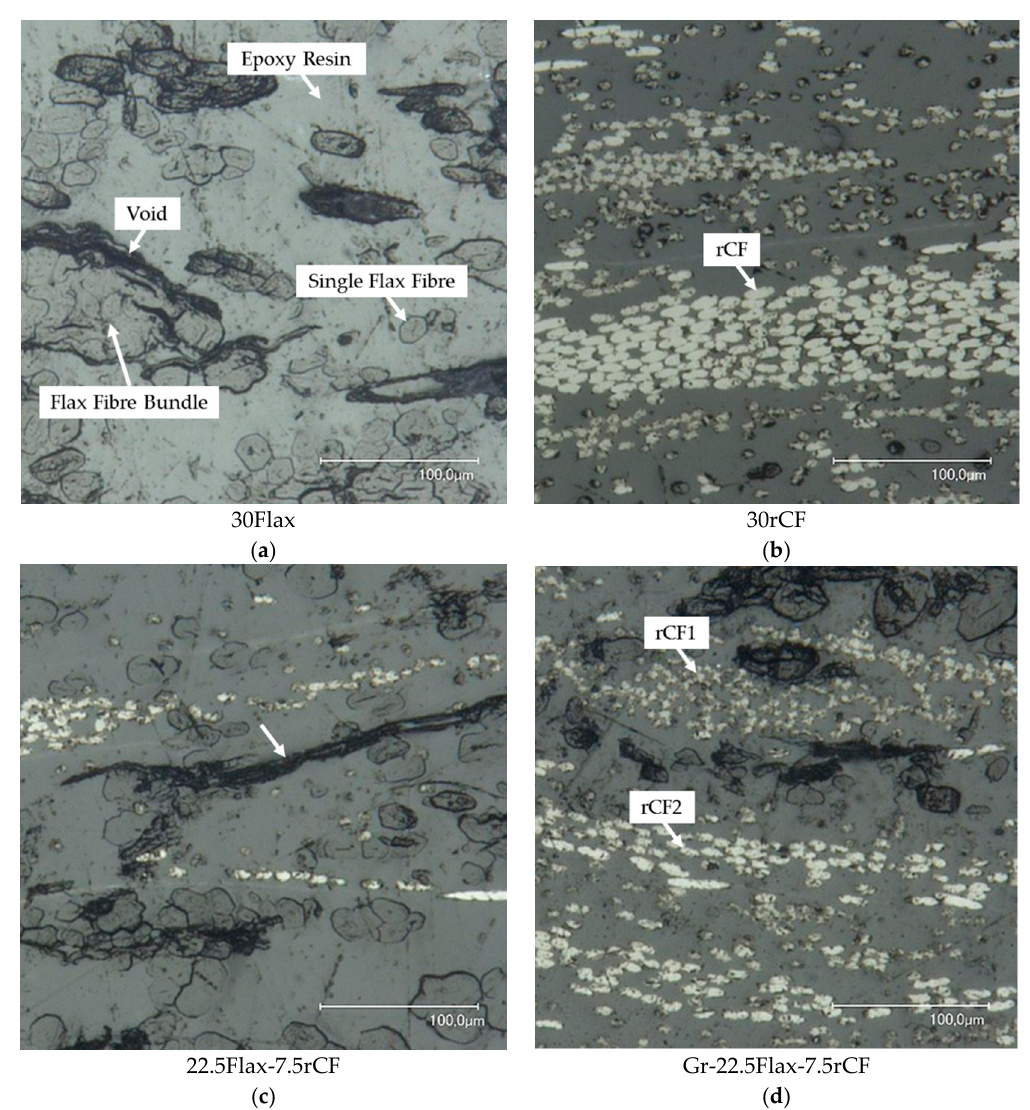
Figure 6. The micrographs show exemplary images of the fibres and their distribution in a 0° laminate direction, corresponding to the nonwoven machine direction. Reference composites of flax and rCF are shown in ( a ) respectively ( b ). All images show areas near the upper or lower surface of the composites in order to give a better distinction of the amount of rCF relative to flax fibres in the homogeneous hybrid composite ( c ) compared to the concentration of rCF in the outer layers ( d ). Voids between fibre and matrix are visible as dark areas. The elongated dark areas, as indicated by the arrow in ( c ) are probably flax fibres oriented near 90° laminate direction that were removed during the polishing process of the microscopy specimens.